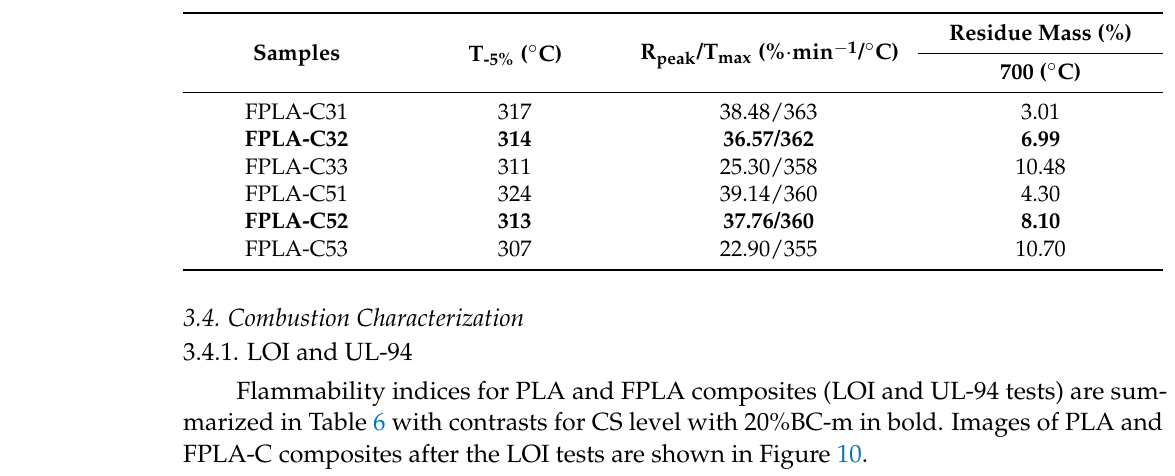
Table 6. LOI and UL-94 results of PLA and FPLA